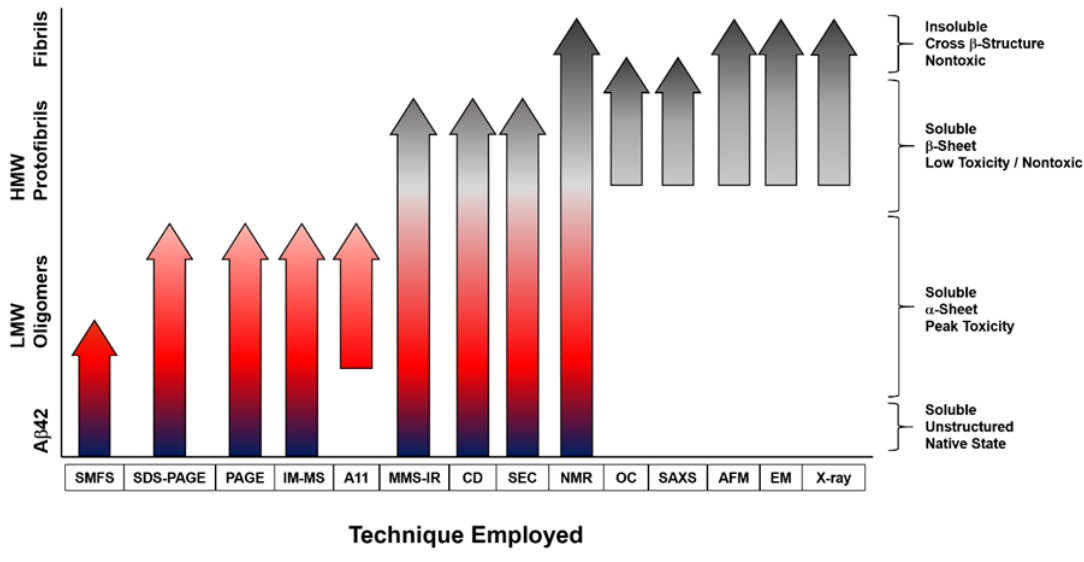
Figure 2. Isolation techniques and aggregate characteristics of toxicity and structure. Arrows span the molecular weight range that each technique can be used to characterize. Dark blue indicates largely unstructured, random coil species, red indicates assemblies that have been determined as the α -sheet-containing primary toxic aggregates, and gray indicates the HMW β -sheet aggregates and fibrils. The very LMW aggregates are soluble, unstructured, and largely nontoxic, while the intermediate 6 –12 mers contain α -sheet and are the most toxic. HMW oligomers and fibrils contain β -sheet and are nontoxic.